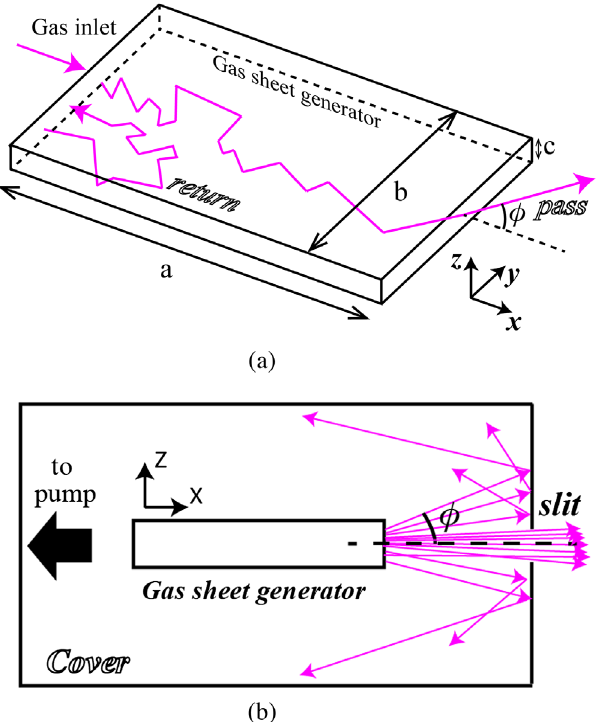
FIG. 3. Schematic diagrams of the formation principle of a gas sheet. (a) A thin and long gas conduit makes a gas sheet. (b) A cover slit eliminates the gas molecules that have large angle ϕ